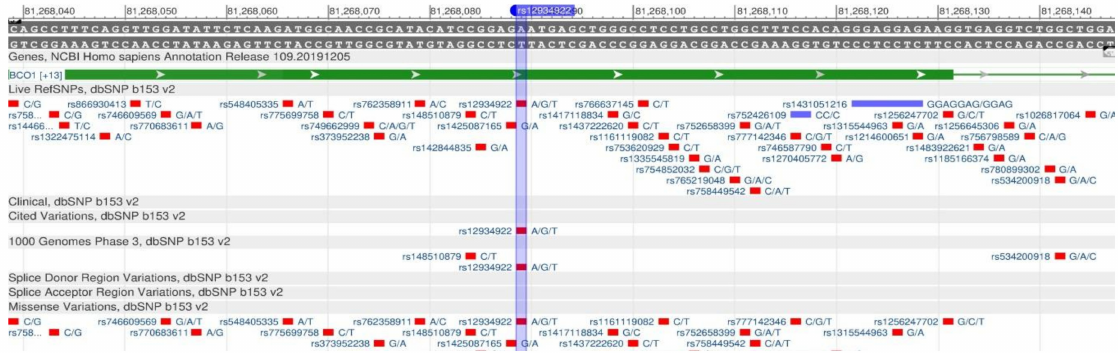
Figure 16. The BCMO1 gene region (located on the long (q) arm of chromosome 16) containing the oligonucleotide polymorphism rs12934922.